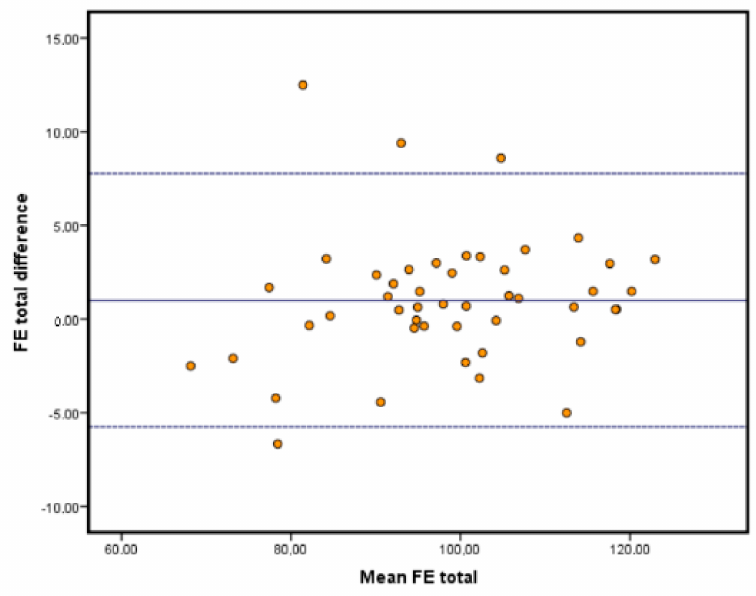
Figure 4. Bland-Altman plot flexo-extension